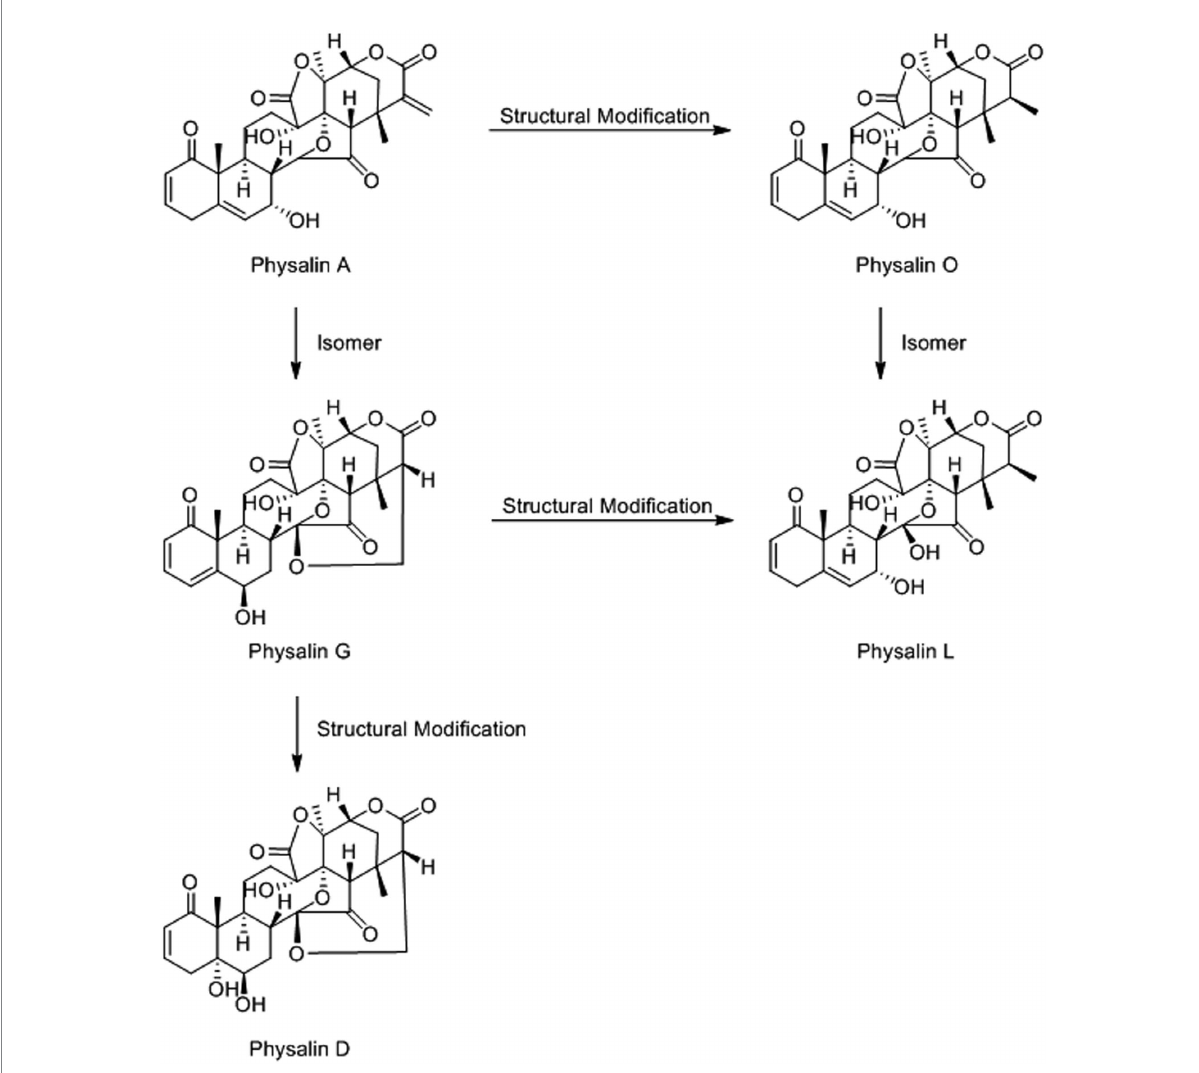
FIGURE 3 The structural association among physalin A and other physalins. Those five physalins could be categorized into two types: the differences among physalin A, physalin D and physalin G is mainly at the ring between 27-C and 14-OH. Besides, there two morphological of 27-C among physalin A, physalin O and physalin L. And, the detailed differences are in the quantity and distribution of the different functional